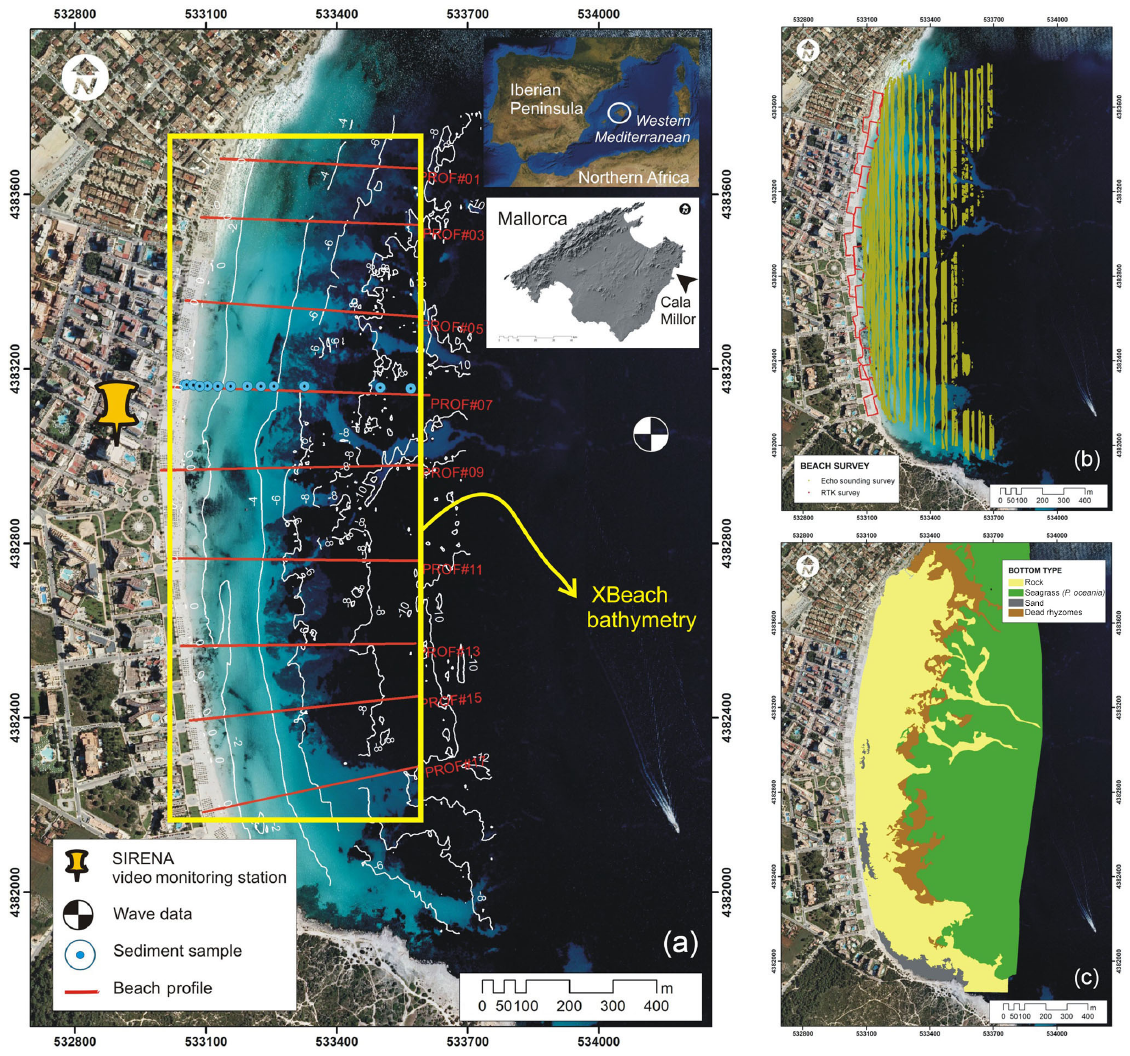
Figure 1. Study site location (a) and major features of Cala Millor. (b, c) White dashed lines correspond to the bathymetric survey (isoline equal distance of 2m); the yellow frame covers the bathymetry area obtained by means of XBeach, and red lines correspond to the beach profile described in text. The bottom orthophoto is provided by the Govern de les Illes Balears-SITIBSA (June 2008). Panel (b) shows the combination of multibeam bathymetric survey (green points) and RTK–GPS survey for dry beach and very shallow submerged beach (red points). (c) Bottom type at Cala